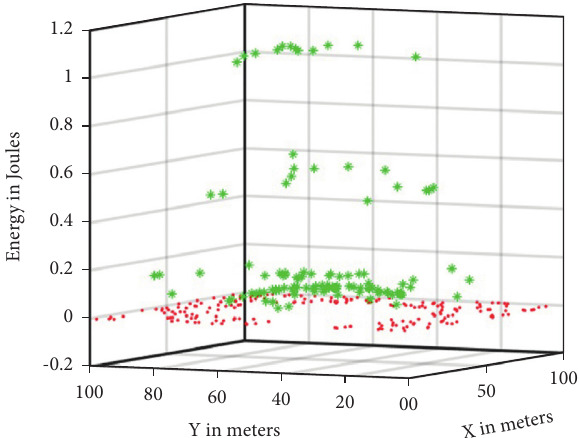
Figure 8: The residual energy of the network after 5000 rounds in 20% of the heterogeneous energy of 300 nodes.